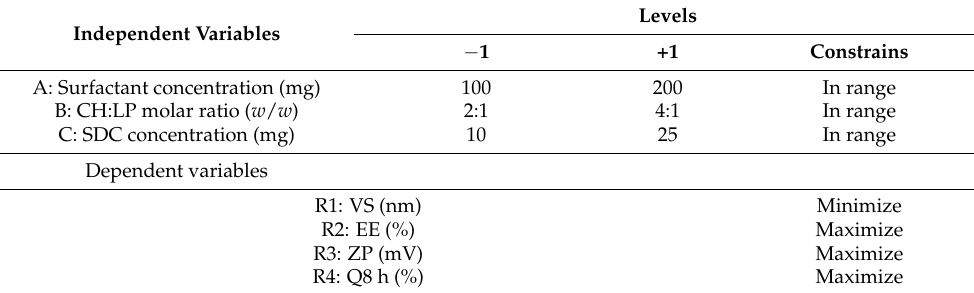
Table 1. 2 3 full factorial design variables and